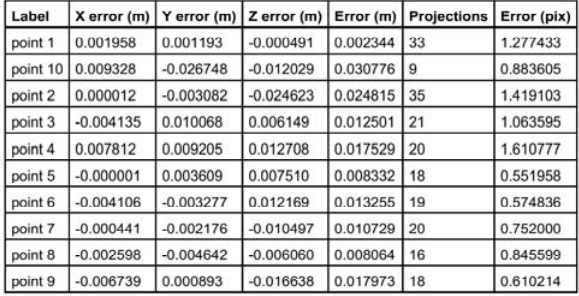
Figure 8: This shows Agisoft PhotoScan calculated errors between the GPS control point positions and the positions calculated for the same points in the 3D model